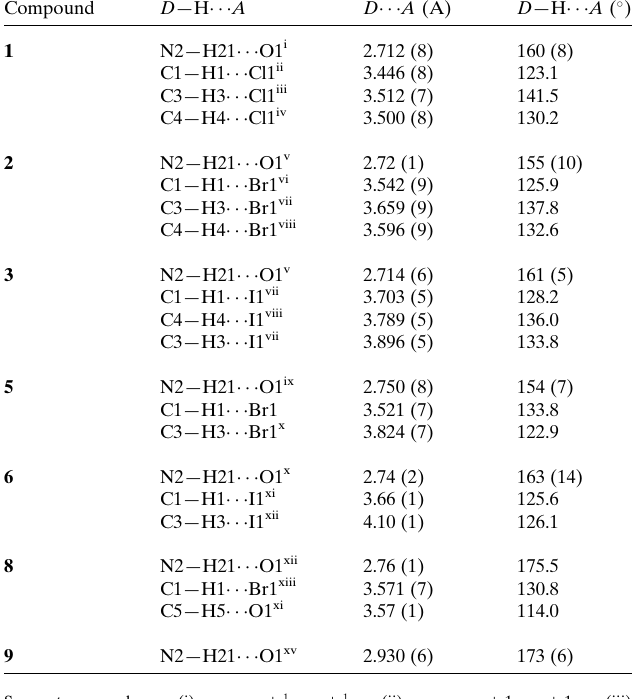
Table 1 Hydrogen-bond geometries for compounds 1 – 3 , 5 , 6 , 8 and 9 . Compound